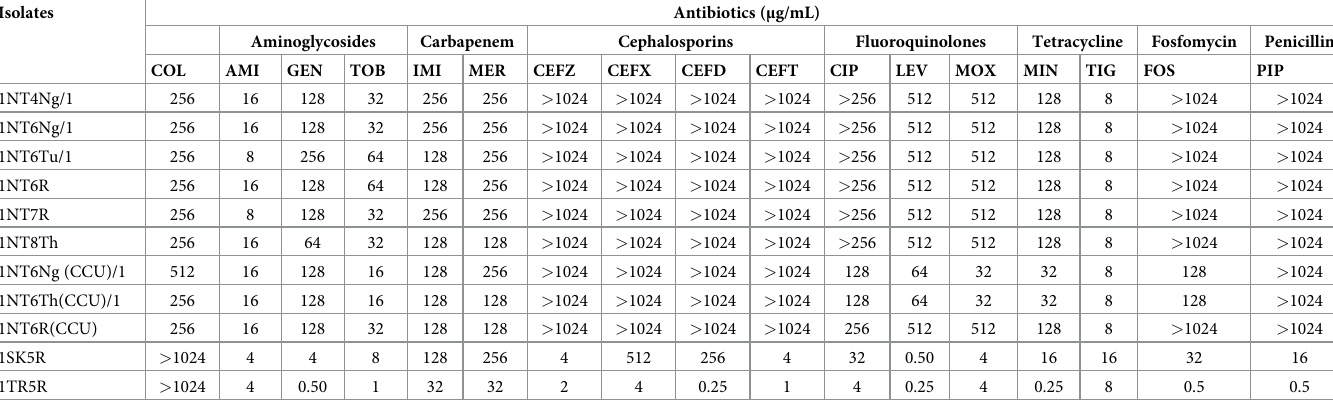
Table 3. Minimum inhibitory concentrations of colistin resistant K. pneumoniae isolates against conventional antibiotics.